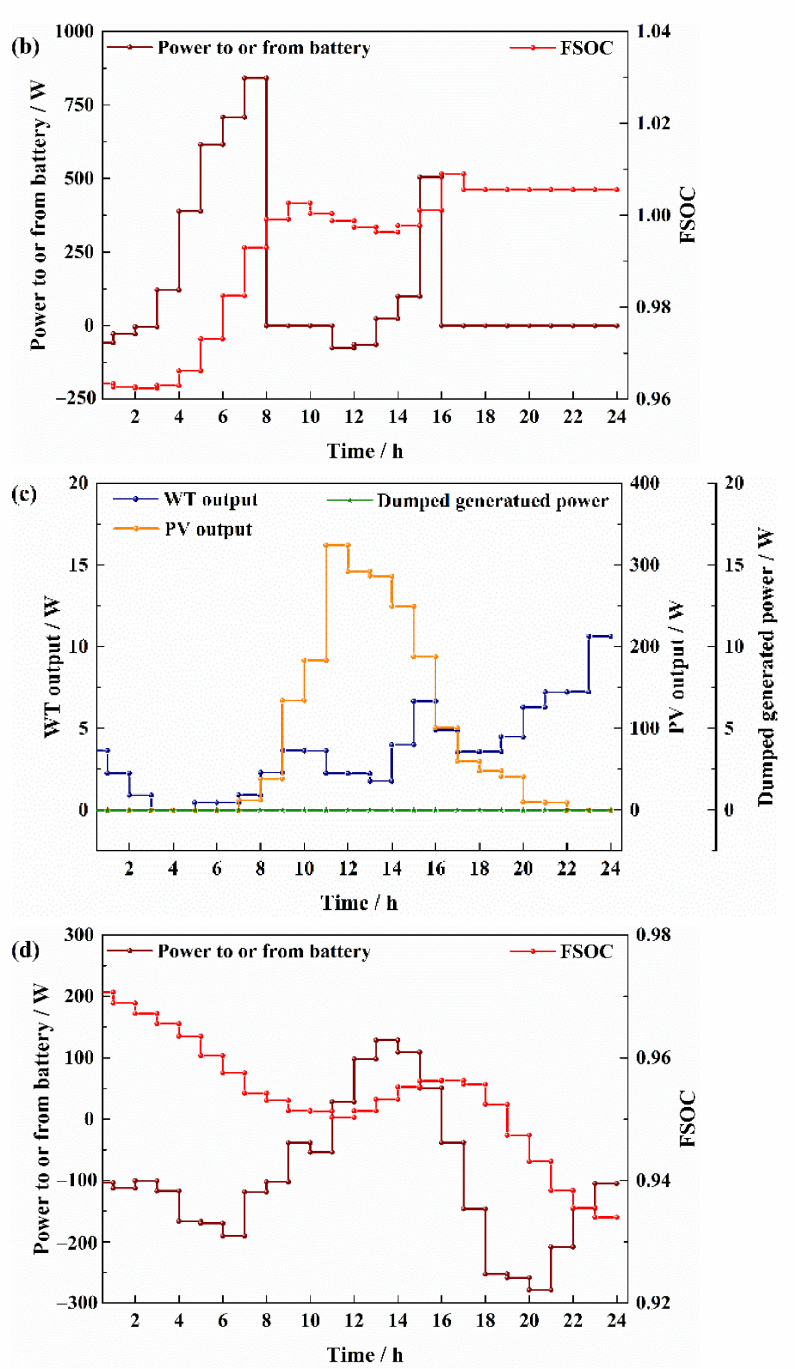
Figure 9. Hourly characteristics when the installed capacity ratio of WT and PV is 5:1 in Kaba-He: ( a , b ) for 15 January; ( c , d ) for 15